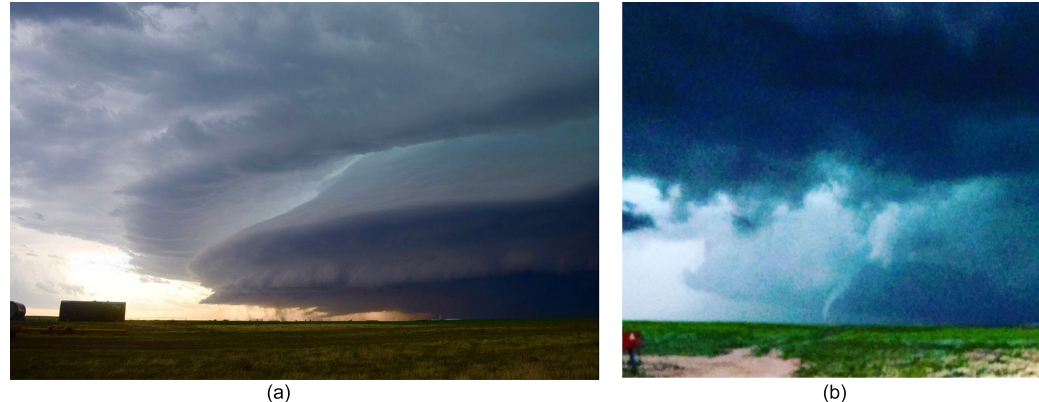
Figure 7. (a) Picture of the storm system that produced the tornado near Lakin, KS, on 22 May 2020. (b) Picture of the Lakin, KS, tornado. Photo credit: Val and Amy Castor.